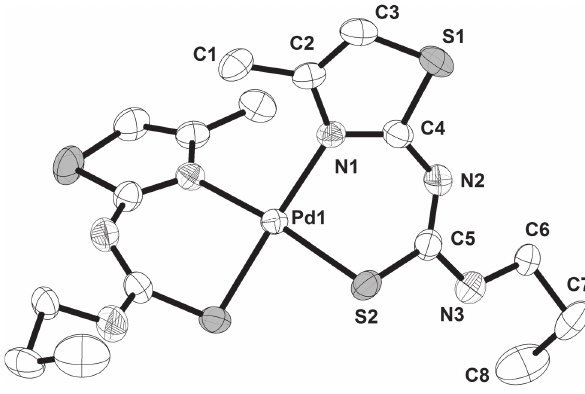
Table 2: Fractional atomic coordinates and isotropic or equivalent isotropic displacement parameters (Å 2